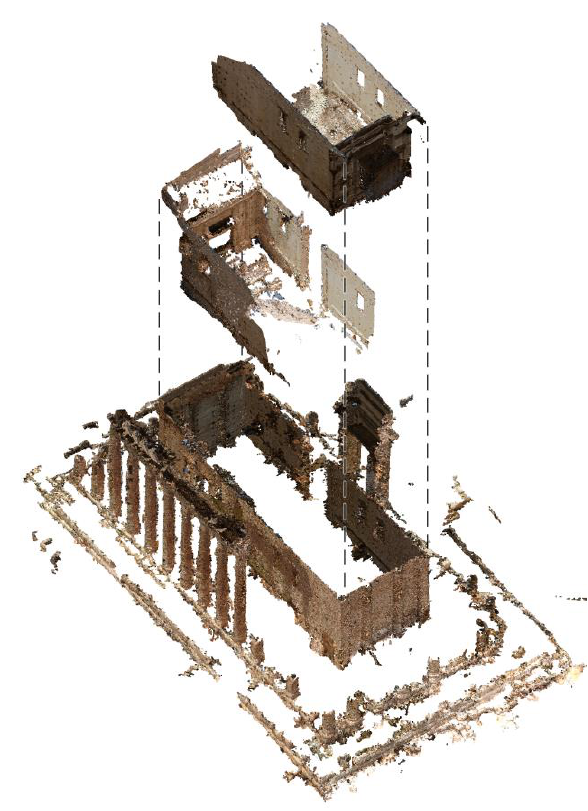
Figure 4: The resulting three point clouds of the temple: interior northern part (top); interior southern part (middle) and the exterior one